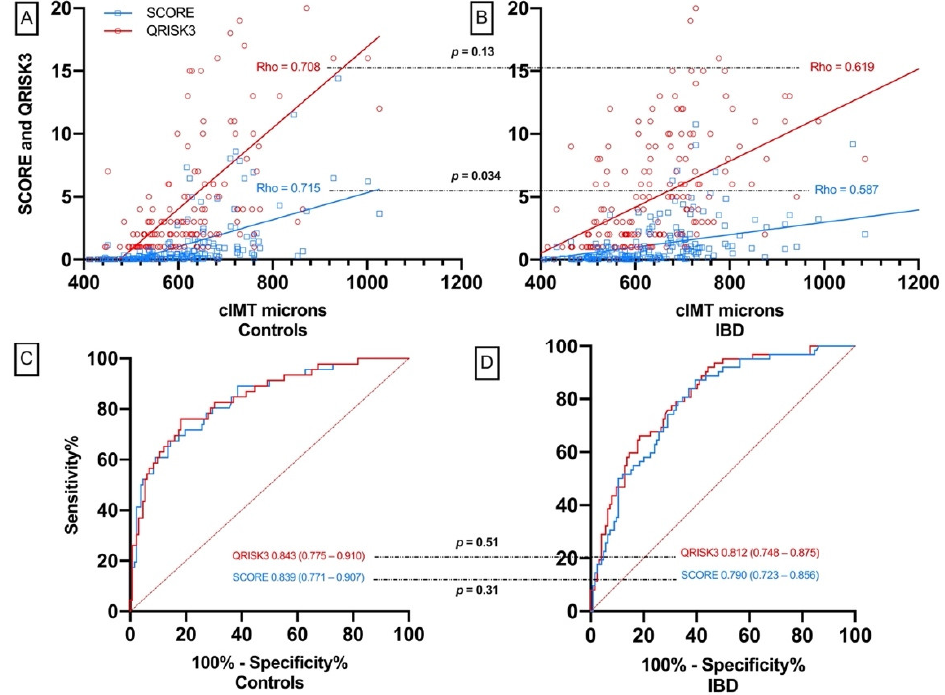
Figure 1. Relation of QRISK3 and SCORE to cIMT and carotid plaque in IBD patients and controls. Comparison between patients and controls are additionally shown. ( A ) relation of cIMT to SCORE and QRISK3 in controls. ( B ) relation of cIMT to SCORE and QRISK3 in IBD patients. ( C ) ROC of SCORE and QRISK3 to carotid plaque in controls. ( D ) ROC of SCORE and QRISK3 to carotid plaque in IBD